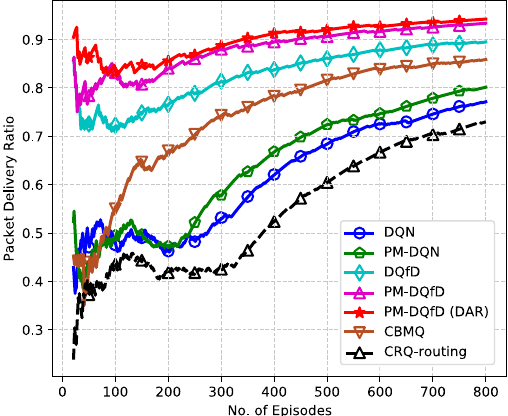
Figure 11. Packet delivery ratio versus number of episodes.